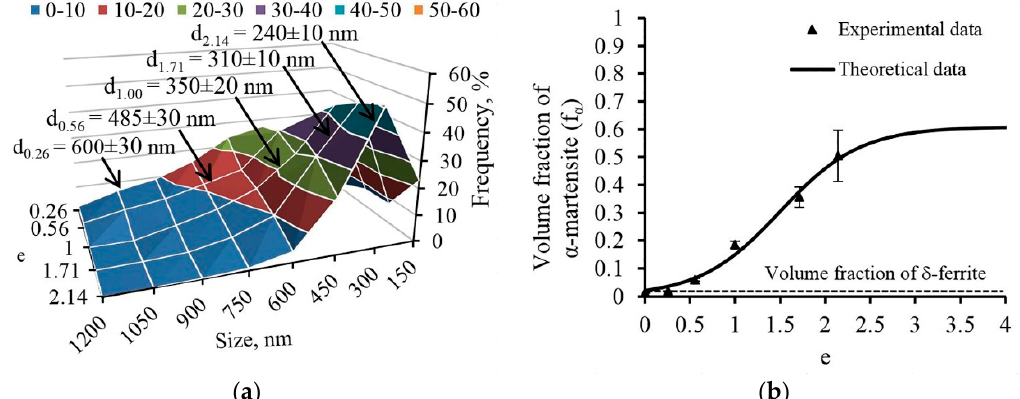
Figure 4. ( a ) The size distribution of substructure elements of the 321 MASS after deformation with different degrees; ( b ) The proportion of deformation-induced α ’-martensite in the structure according to the experiment (points) and the approximation of experimental data (line) depending on true strain. Note: d e is the average size of the substructure elements, which were obtained after deformation with the degree e .